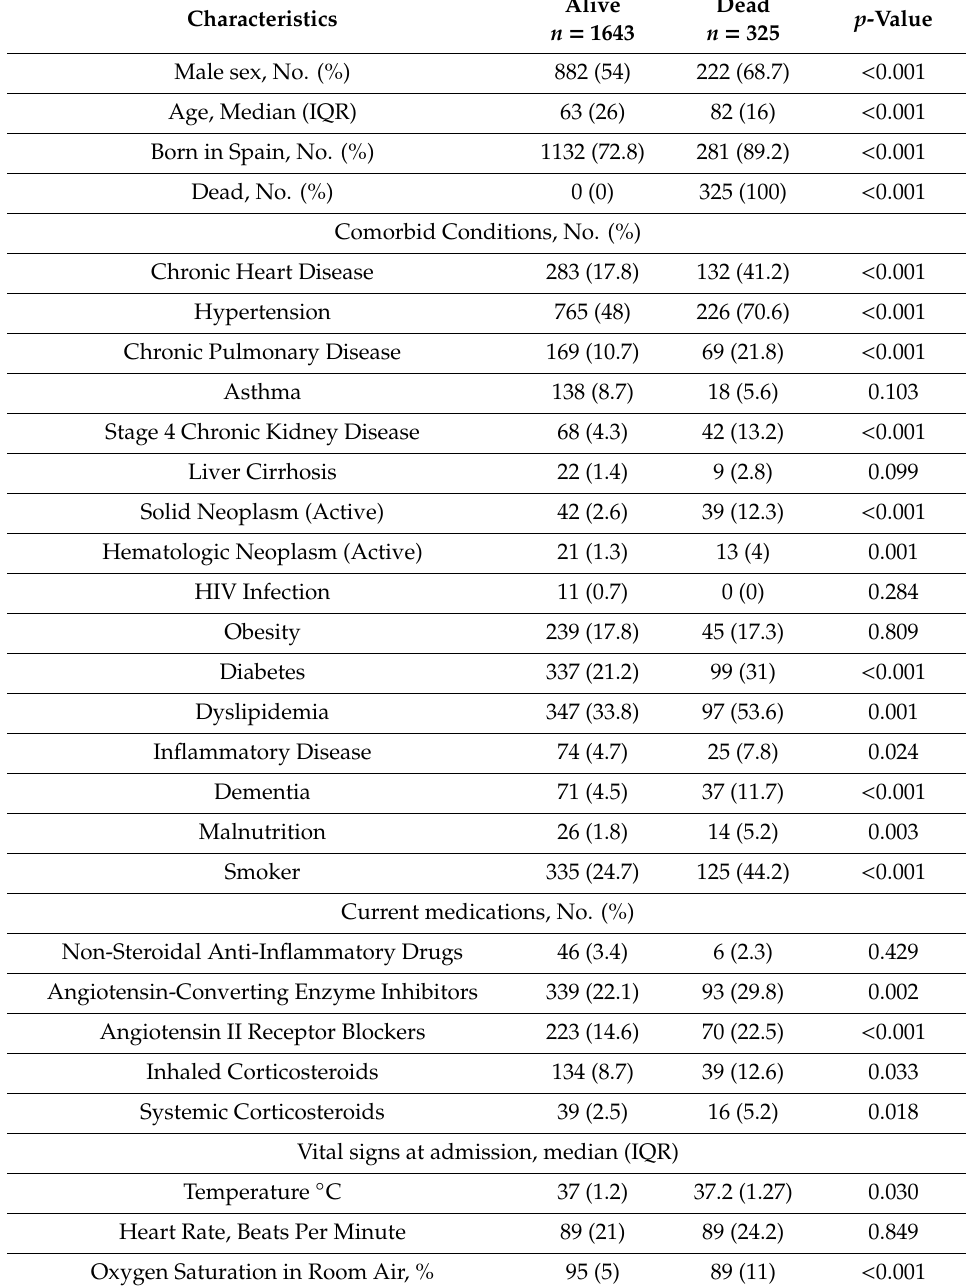
Table 1. Demographics and comorbidity data of 1968 hospitalized patients with COVID-19 stratified by